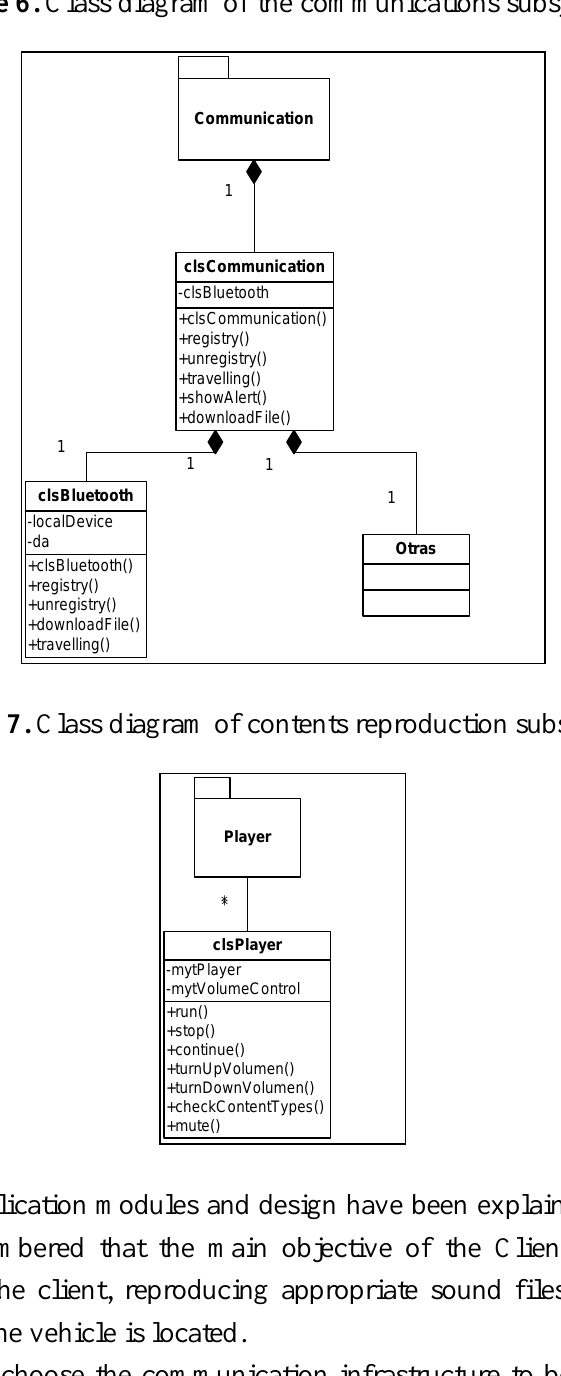
Figure 6. Class diagram of the communications subsystem.